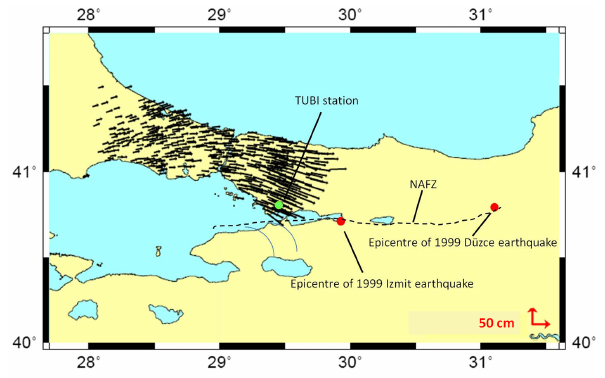
Fig. 7. The horizontal displacement vectors relative to the ANKR station, the epicentres of Izmit and D¨uzce earthquakes, and loca- tions of TUBI and the